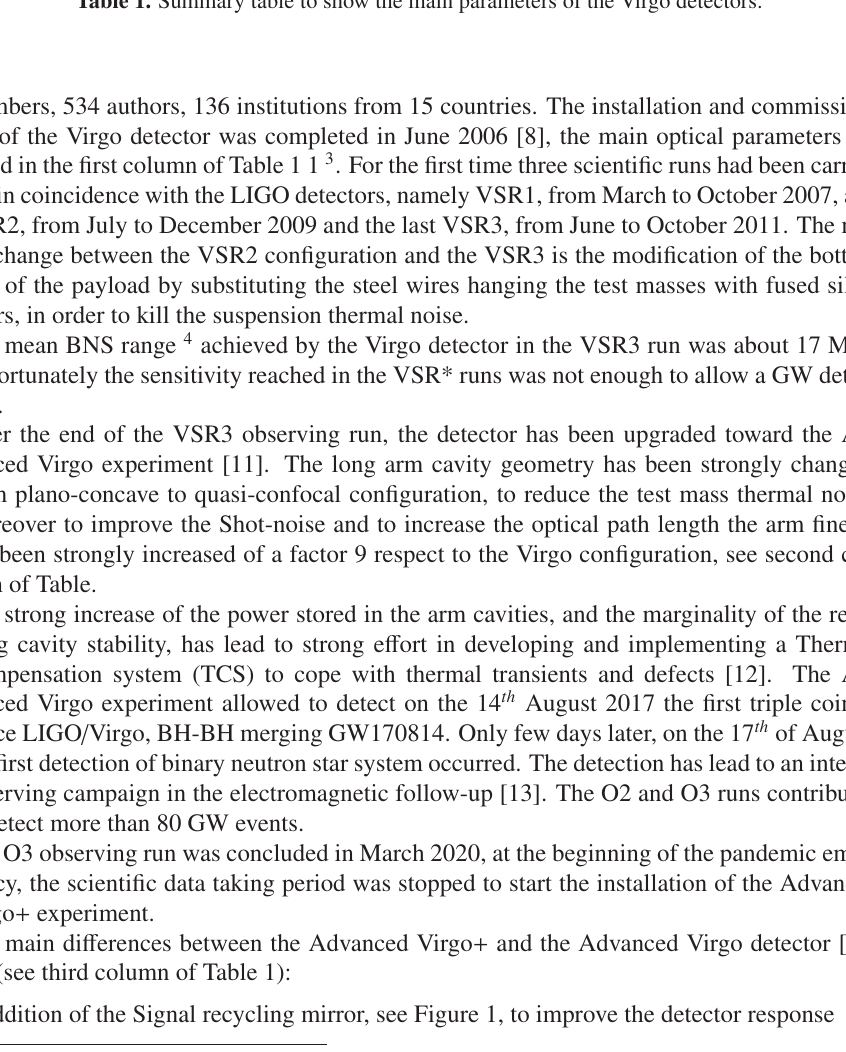
Table 1. Summary table to show the main parameters of the Virgo